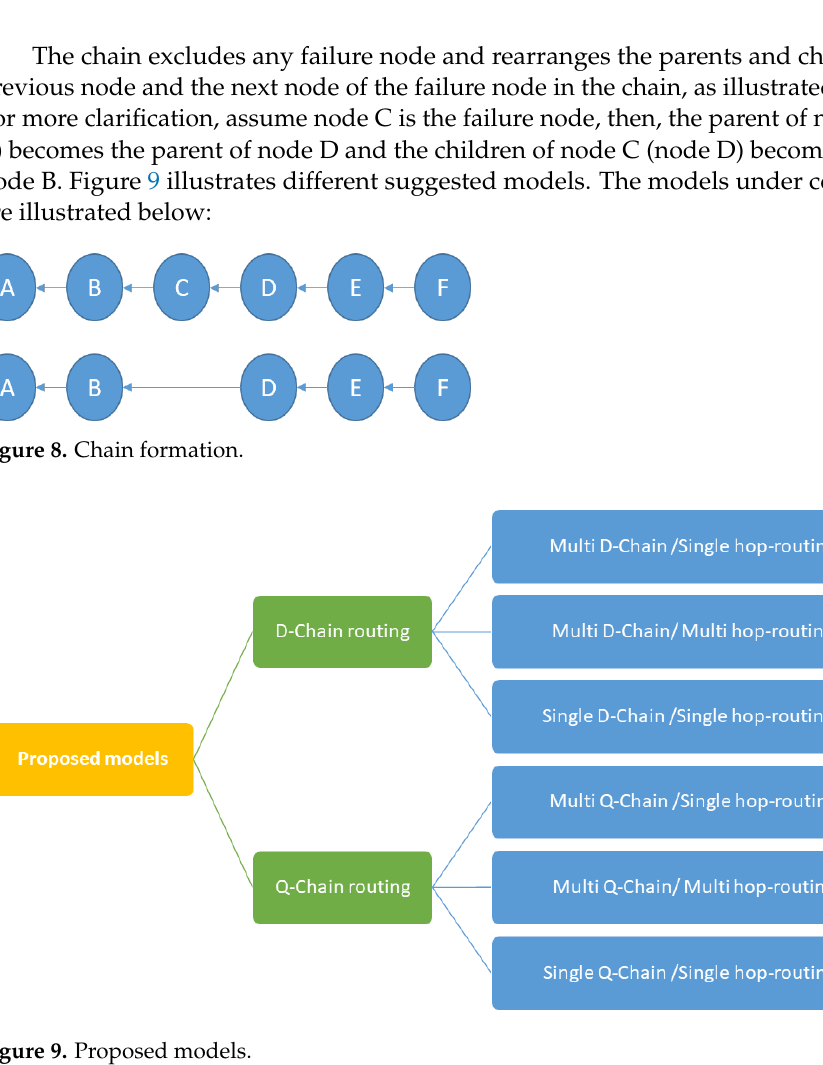
Figure 9. Proposed models.